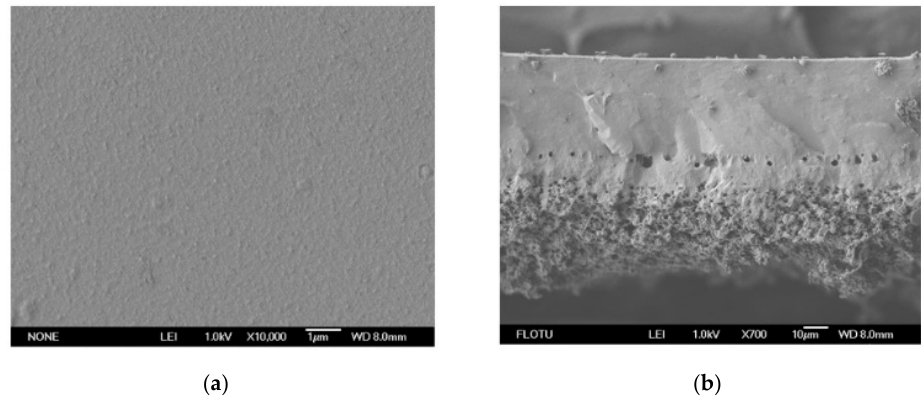
Figure 1. SEM images of composite PDMS/PVDF membrane: ( a ) Surface; ( b )